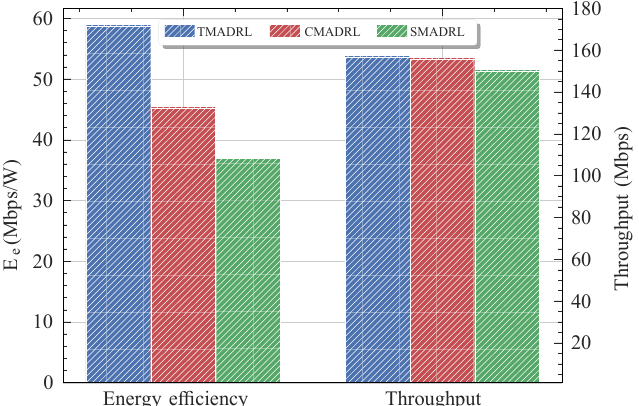
Figure 5. Average energy efficiency ( E e ) and throughput performance metrics for the TMADRL, CMADRL and SMADRL